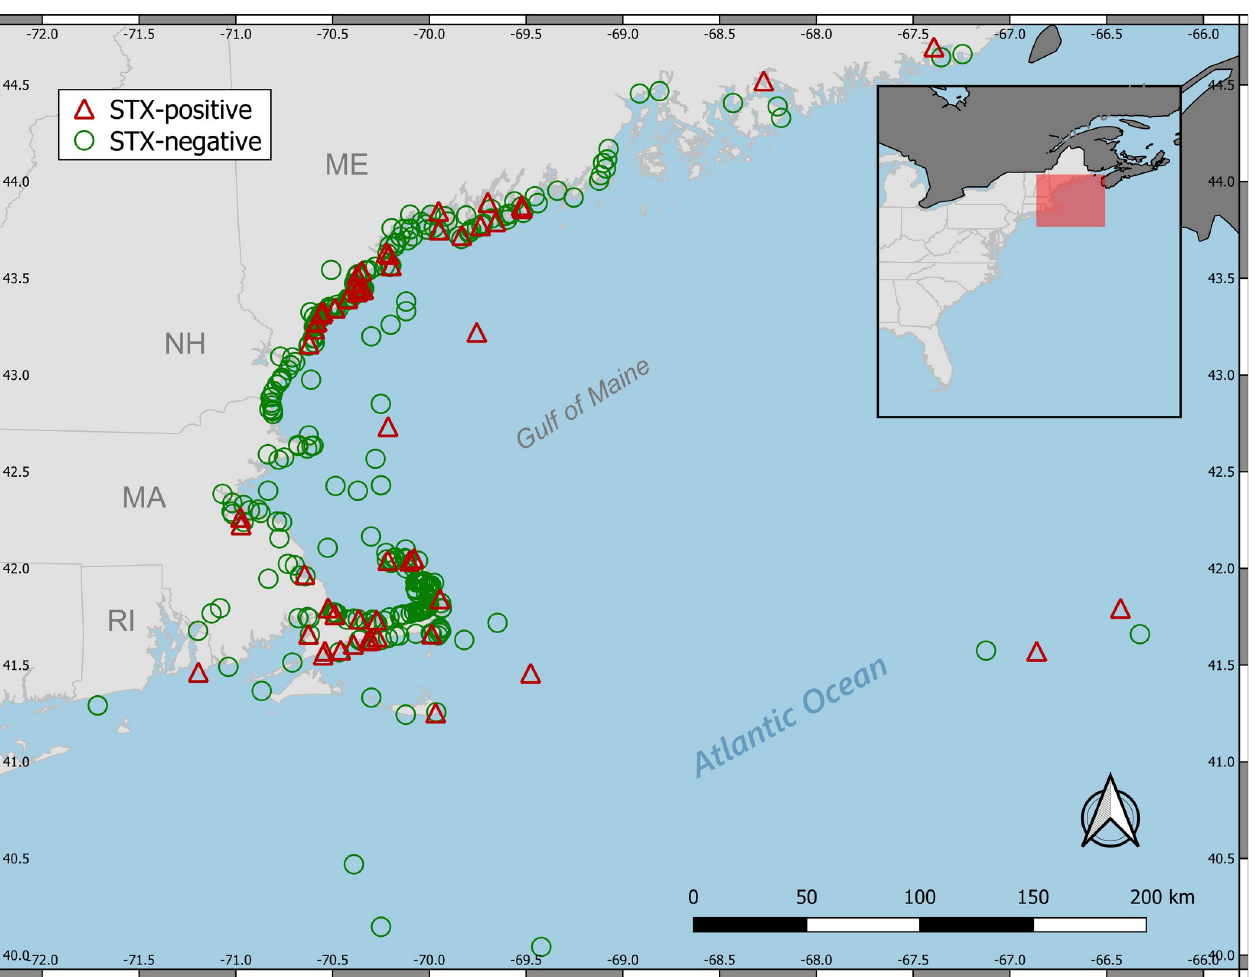
Fig 1. Animal collection/sampling locations and detections of saxitoxin (presence/absence in at least one sample).